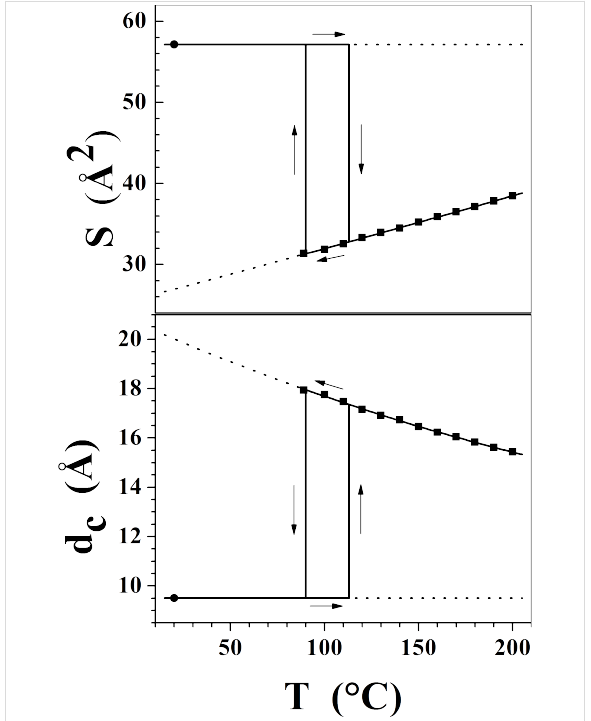
Figure 8: Comparison of the molecular area S and of the ionic sublayer thickness d c (including mesogenic segments) in the crystal- line phase (circle) and in the smectic A phase (squares) for compound 1a (I −